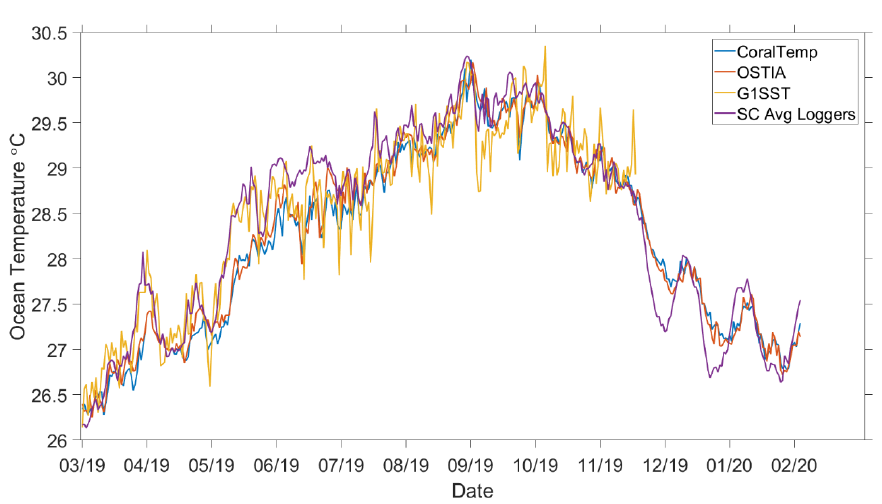
Figure 2. Time series of temperature data from 30 June 2017–1 March 2020 of the three remote sensing datasets (CoralTemp, G1SST, OSTIA) and the averaged in situ loggers for Cayo Enrique and Cayo Mario.